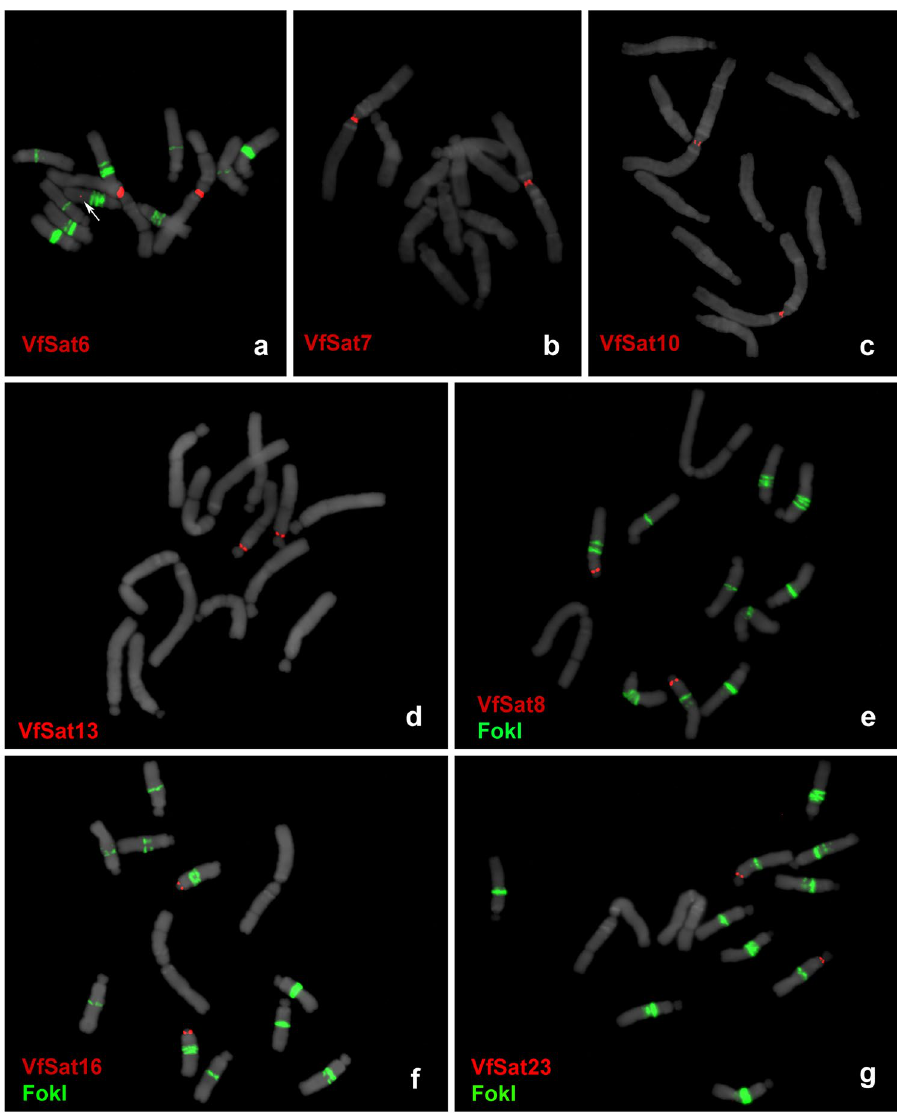
Figure 4. FISH localization of centromeric satellites. Three satellites located in the centromere of chromosome 1 (VfSat6, VfSat7 and VfSat10) are shown separately in panels a–c. Centromeres of four other chromosomes that each contain a single satellite repeat are labeled in panels d–g: ( d ) VfSat13 repeat located in centromere 5, ( e ) VfSat8 in centromere 4, ( f ) VfSat16 in centromere 6, and ( g ) VfSat23 in centromere 2. Arrow in ( a ) points to minor non-centromeric locus of VfSat6 which is detectable only on a fraction of chromosomes. Hybridization patterns of FokI repeats (green signals) were used for chromosome discrimination in ( e–g ). Chromosomes counterstained with DAPI are shown in